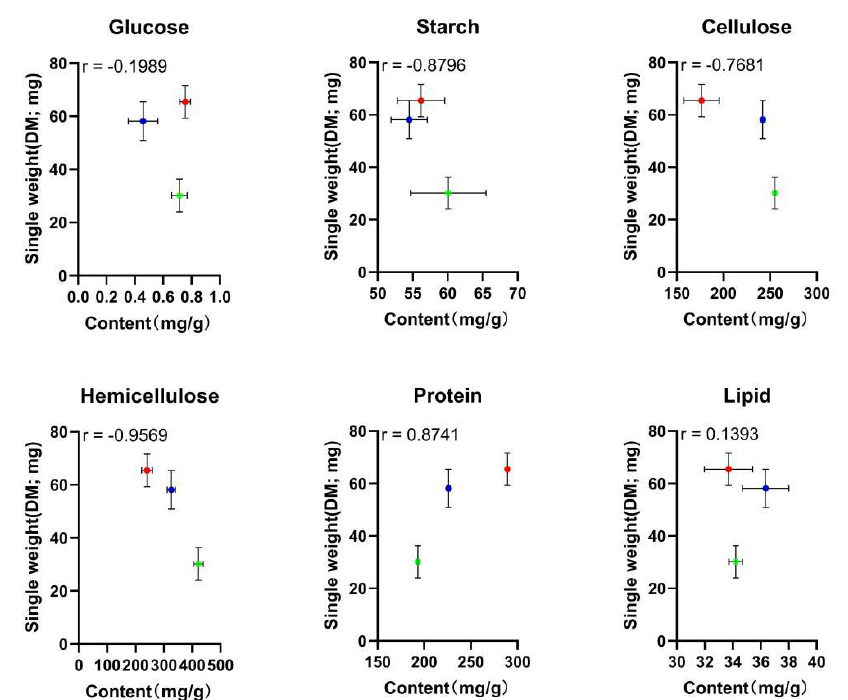
Figure 2. Correlation between the larval single weight and the different nutrient contents. Each point represents the larval single weight of one type of manure plotted against the nutrient content. The r value represents the correlation coefficient; a red circle represents the NM; a blue circle represents the GM; a green circle represents the FM.